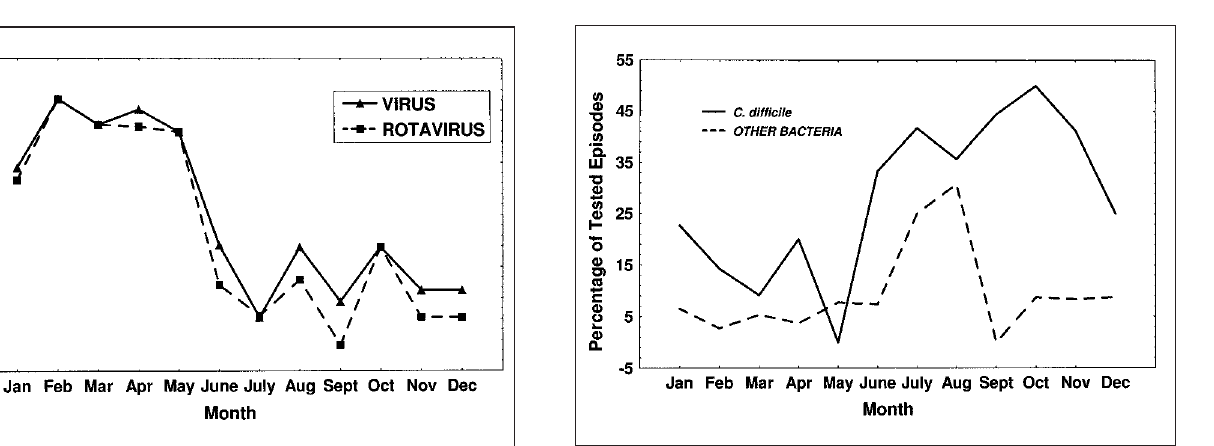
*99 episodes tested for rotavirus, adenovirus and enterovirus – one episode positive for both rotavirus and adenovirus; † 47 episodes tested by both enzyme immunoassay (EIA) and electron microscopy (EM) – one episode positive for rotavirus with both EIA and EM; ‡ 19 episodes tested by both EIA and culture; § 94 episodes tested for C difficile toxin, C difficile by culture and routine bacterial culture; ¶ Other bacteria: Escherichia coli (n=13, 3.0%), shigella (n=6, 1.4%),